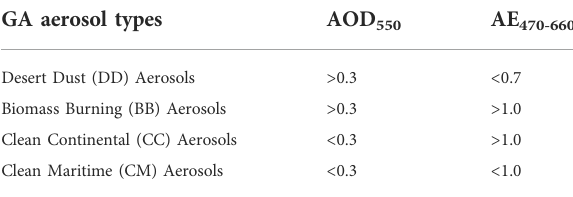
TABLE 3 The GA aerosol types used for evaluation against CALIOP aerosol subtypes and MODIS true-color